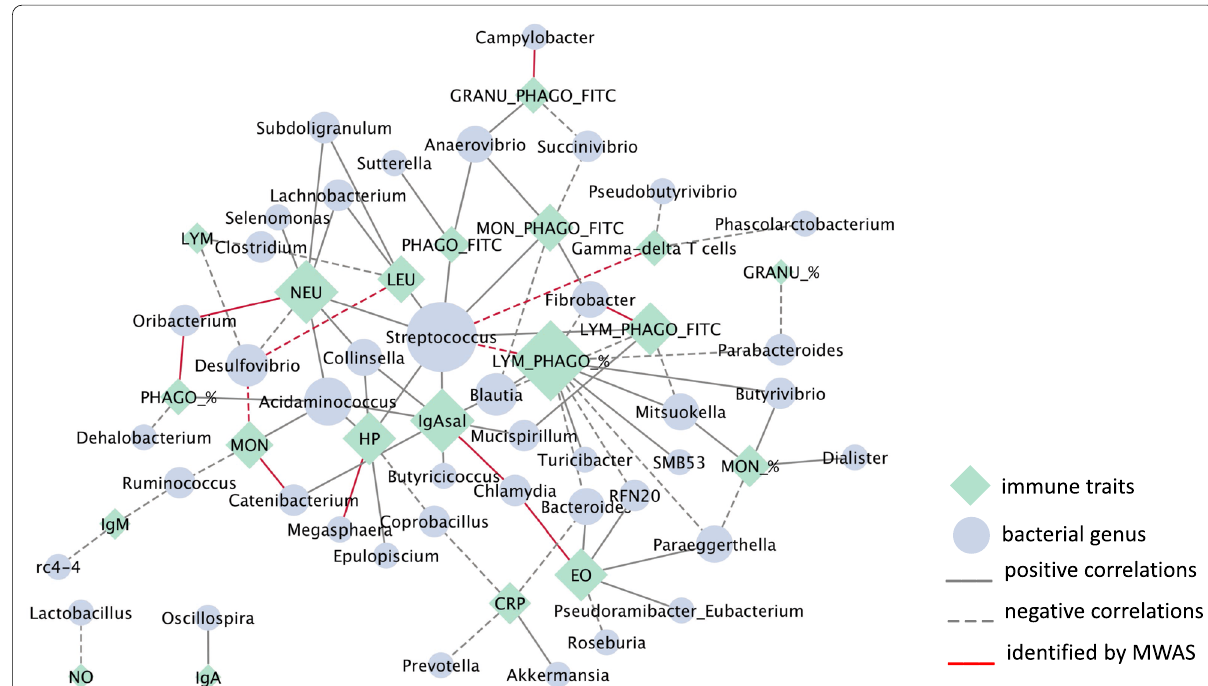
Fig. 2 Microbial—health‑related traits network. Green diamond nodes correspond to immunity traits (n to microbial genera (n 42). Node sizes are relative to their topological degree (number of connections) and edges are continuous or dashed to = represent positive or negative correlations, respectively. Relationships previously identified by MWAS are highlighted in